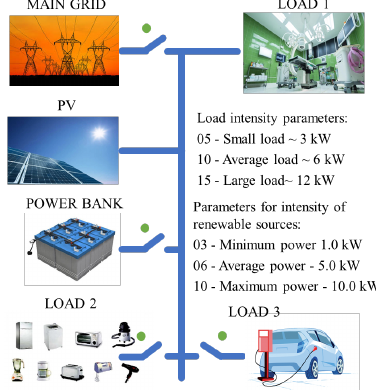
Figure 13. MG SCADA user interface.